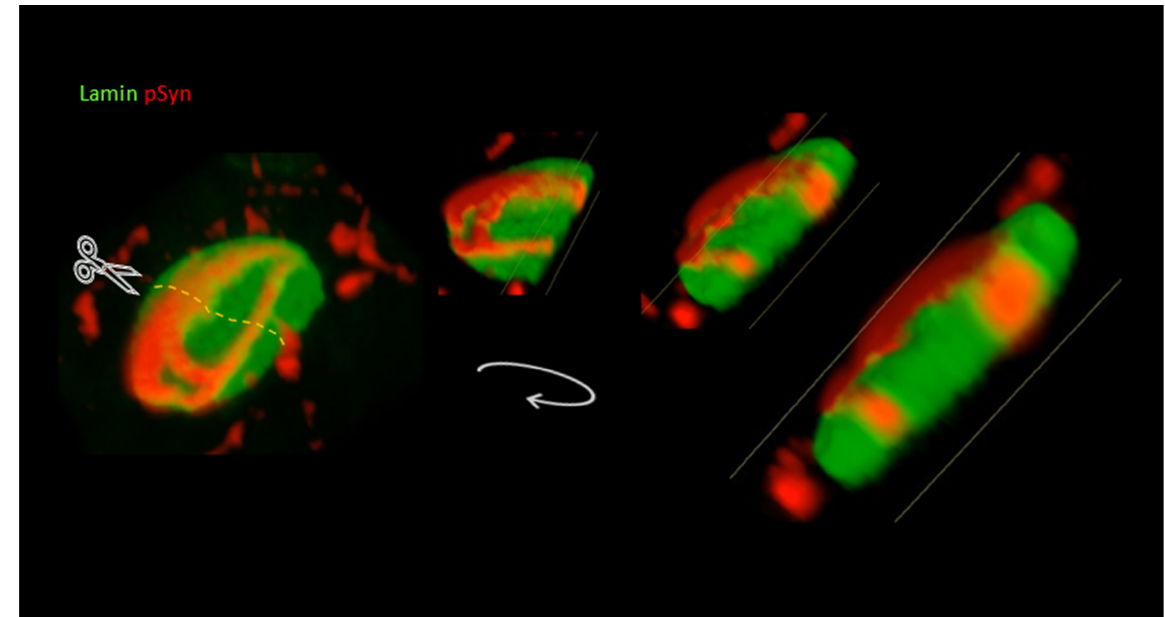
Figure 8. A 3D reconstruction, in silico sectioning (scissors/dots), and 3D rotation of a Z-stack of LSCM optical sections of a single 30 DIV mouse primary cortical neuron treated at DIV7 with 1B fibrils. Nuclear Lamin coded in green; phospho-S129 α -Syn (pSyn) coded in red showing an NII. However, we also encountered a few neurons in which a main NCI was “sending” a thin aggregate process into the nuclear mass forming a filamentous NII. Figure 9 shows a neuron harboring a bifid α -Syn NCI revealed with phospho-S129 α -Syn (red, empty arrowhead) that extends an aggregate process (red, plain arrowhead) deep inside the nucleus (revealed by Lamin, green), thus forming a filamentous NII (plain arrowhead).